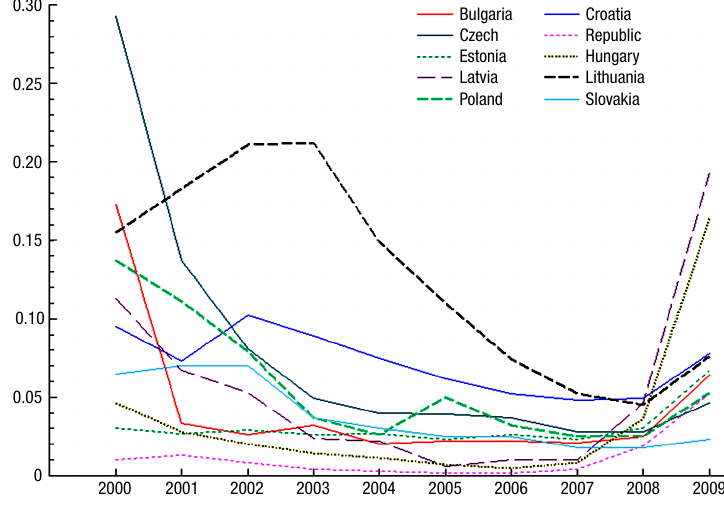
Fig. 1. NPLs ratio dynamics in the CEE